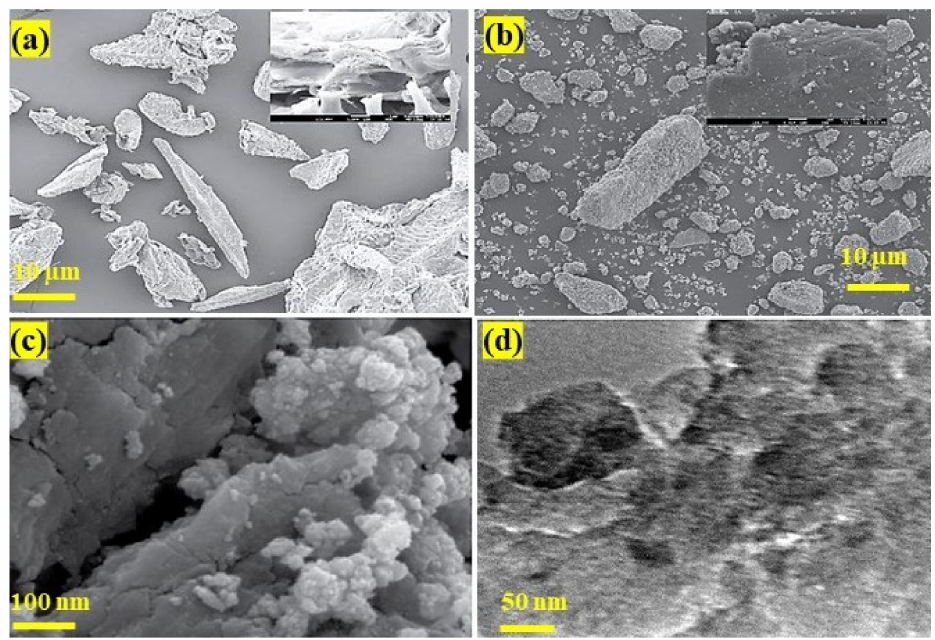
Figure 11. ( a ) SEM micrograph of CCSP, ( b ) CCSP10, ( c ) magnified view of CCSP10, and ( d ) TEM micrograph of CCSP10